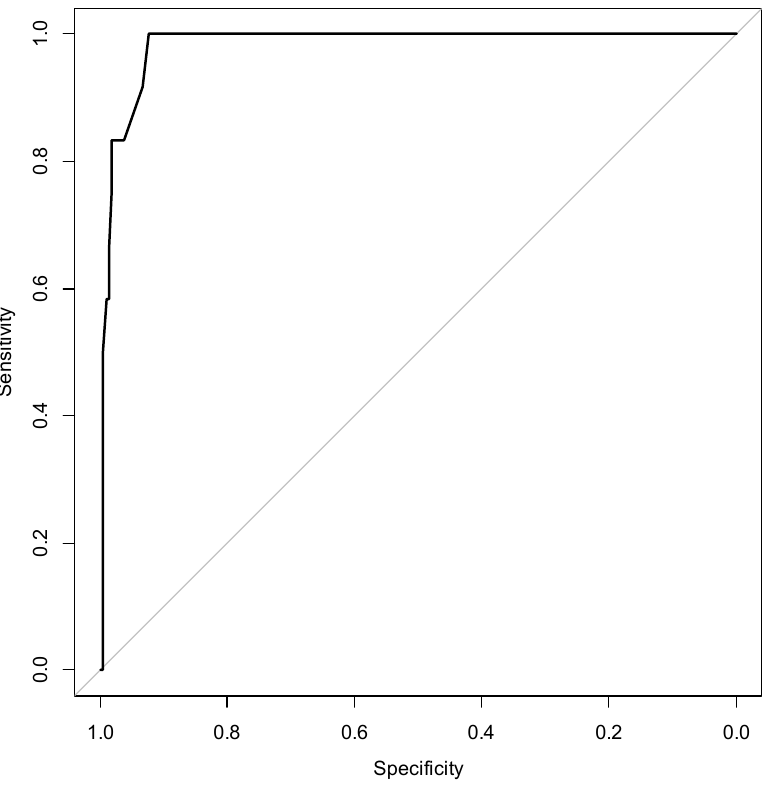
Figure 2. Predictive performance of the risk score for the diagnosis of pancreatic cancer. AUC, area